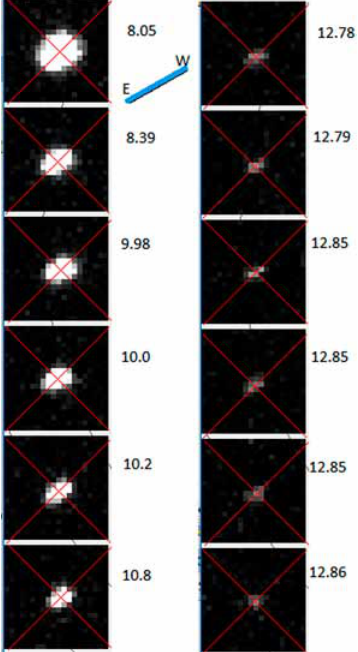
Fig. 2. Star images in a frame (close to Milky Way, 0.5 sec exposure, 2×2 pixel binning). Left: 6 brightest stars; right: weaker stars (#40-46 of 78). East – West direction